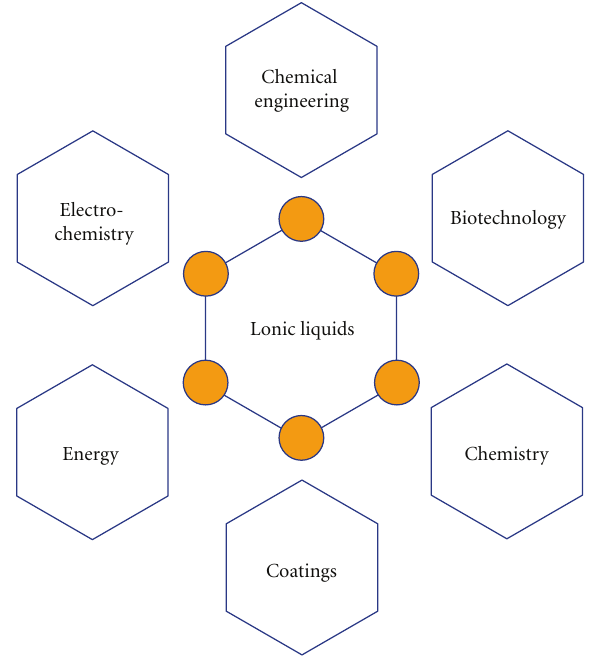
Figure 1: Applications of